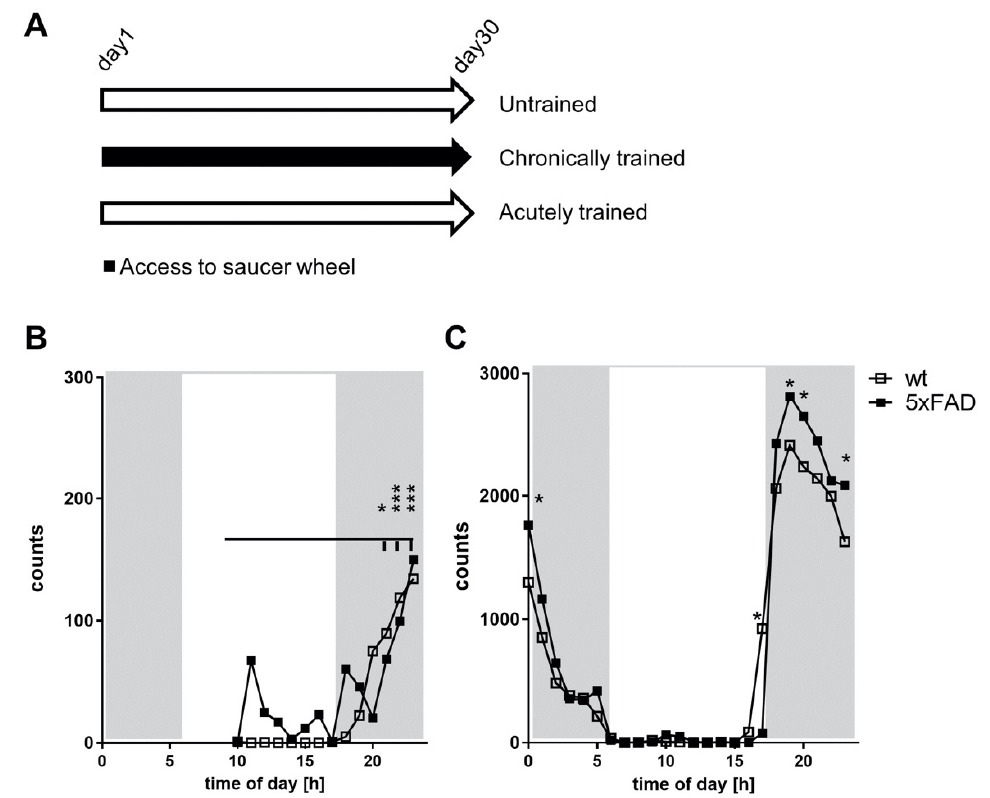
Figure 1. Training groups and the comparison of first night and chronic saucer wheel usage. ( A ) Schematic of the three groups used for the investigation. All animals were single-caged and kept in type II macrolon cages for 30 days. The untrained group had no access to a saucer wheel, the chronically trained group kept the wheel over the whole time period, and the acutely trained mice had access only for the last night. Wheel turning counts per hour were measured for new access to the saucer wheel ( B ) and the chronic usage ( C ). Data are presented as mean of the performance over the 30 days of the chronically trained mice ( n = 10 for wild-type, n = 8 for 5xFAD mice). Error bars are not visualized for clarity of the graph. Statistical analysis: multiple unpaired t-tests (* p < 0.05; *** p < 0.001).